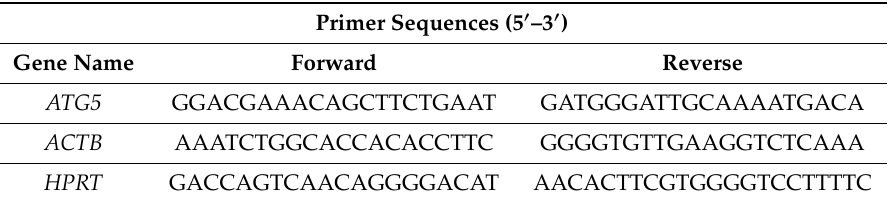
Table 2. Sequences of primers used for